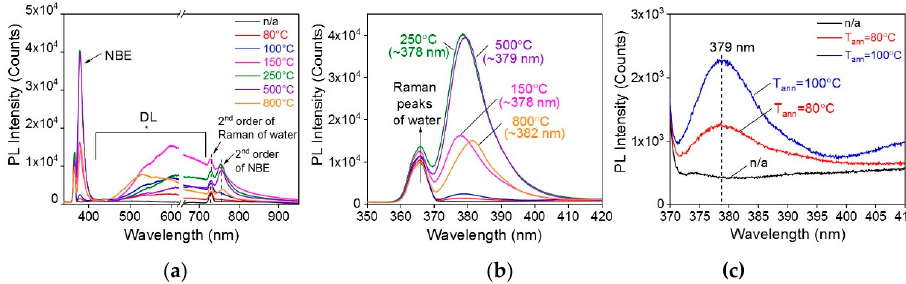
Figure 8. Photoluminescence of ZnO NP dispersed in water: ( a ) The full photoluminescence (PL) spectrum of all samples before and after annealing and showing break line at the missing data points over the region of the second order of the laser, ( b ) a zoom in the ZnO UV region of the PL spectrum showing the maximum position of the UV emission wavelength, ( c ) a zoom in the ZnO UV region of the PL spectrum of the non-annealed (n/a) ZnO and the annealed ZnO at 80 and 100 °C.